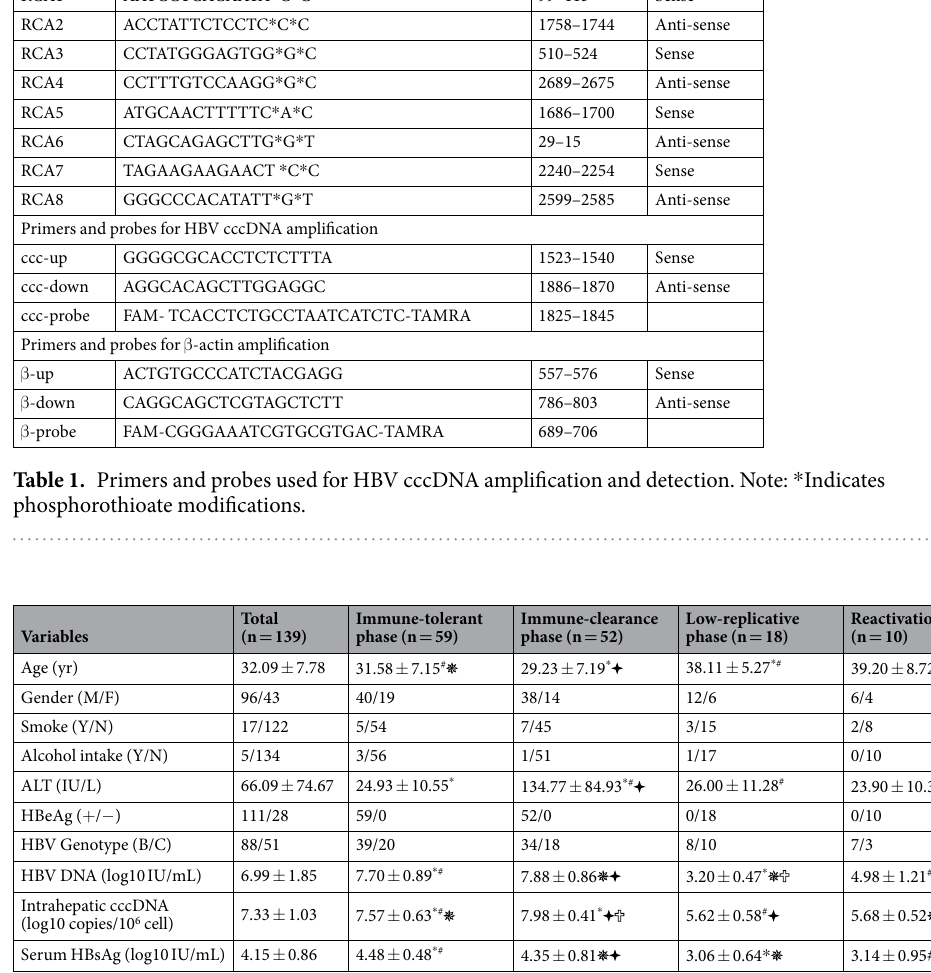
Table 2. Demographic and clinical characteristics of patients in this study. Note: The symbols represent significant difference between two groups with P ≤